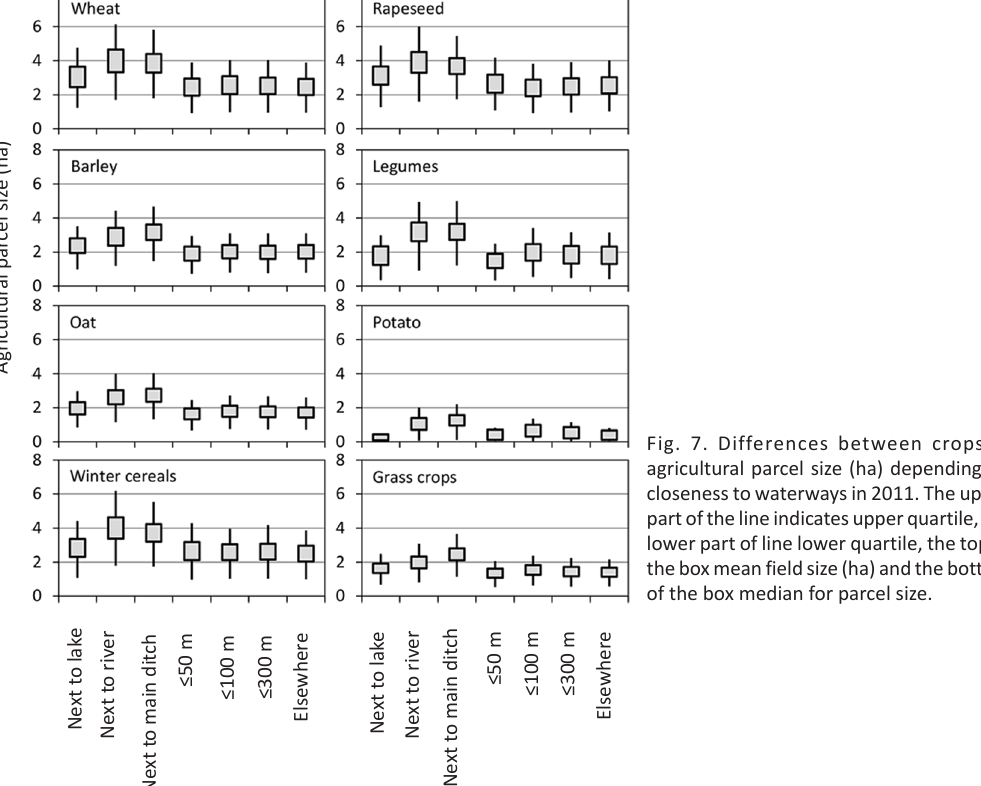
Fig. 7. Differences between crops in agricultural parcel size (ha) depending on closeness to waterways in 2011. The upper part of the line indicates upper quartile, the lower part of line lower quartile, the top of the box mean field size (ha) and the bottom of the box median for parcel size.